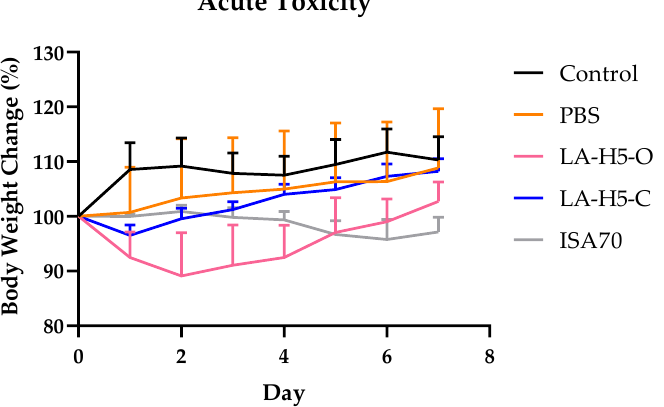
Figure 4. Acute toxicity assay of the vaccines. LA-H5-O: ****, LA-H5-C: *, ISA70: **** (compared with control). LA-H5-O: ***, LA-H5-C: P >0.5, ISA70: * (compared with PBS), determined by one-way ANOVA using Tukey’s posttest. Control: no vaccination. C: 1% carbomer. O: mineral oil with water-in-oil formulation. LA-H5-C: 0.5 U LA particles with trehalose, emulsifiers, and carbomer. LA-H5-O: 0.5 U LA particles with trehalose and emulsifiers, and mineral oil with water-in-oil formulation. ISA70: Montanide ISA70 adjuvant. *: p < 0.05, **: p < 0.01, *** : p < 0.001, and **** : p < 0.0001. Data are presented as the mean ± SEM and determined by one- way ANOVA using Tukey’s posttest.